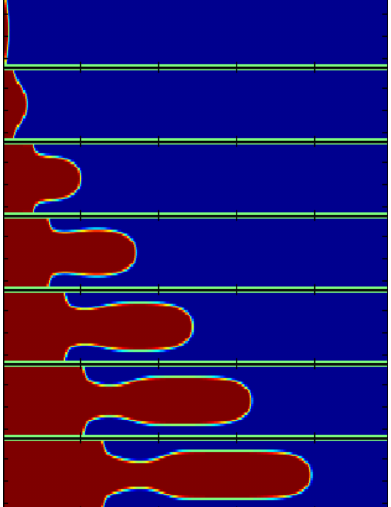
Figure 3. Capillary fingering evolution for viscosity ratio 20 at equal time intervals of 1000 time steps from top to bottom with a surface tension of 0.00496. The tip velocity is 0.05.